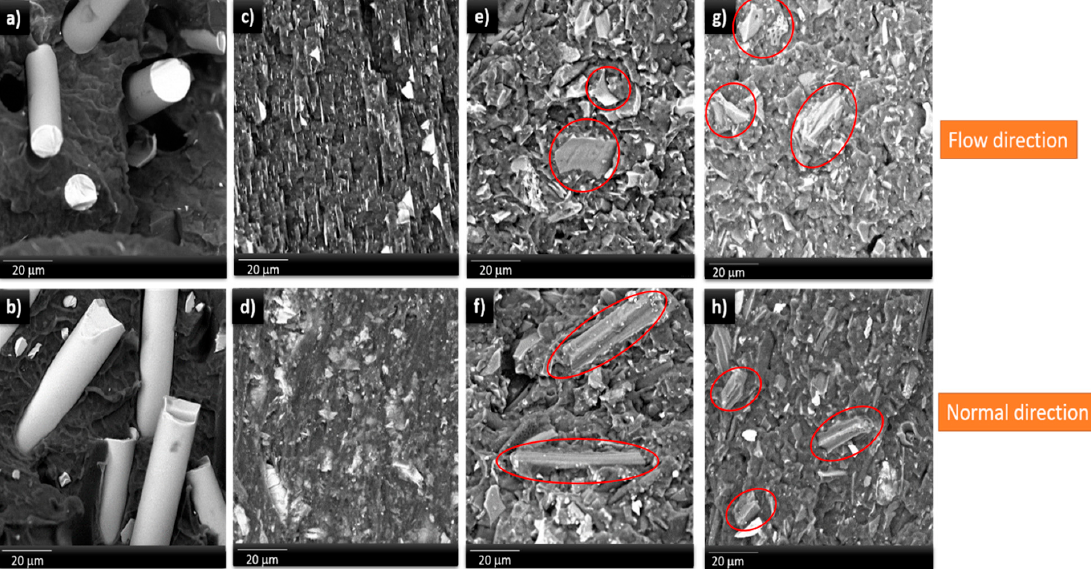
Figure 2. SEM images of PP with 30 wt.% ( a , b ) glass fiber; ( c , d ) talc; ( e , f ) BC 650 and ( g , h ) BC900 at 3000 × . ( a , c , e , f ) in flow direction and ( b , d , f , h ) in normal direction (the red ovals indicate biocarbon particles).